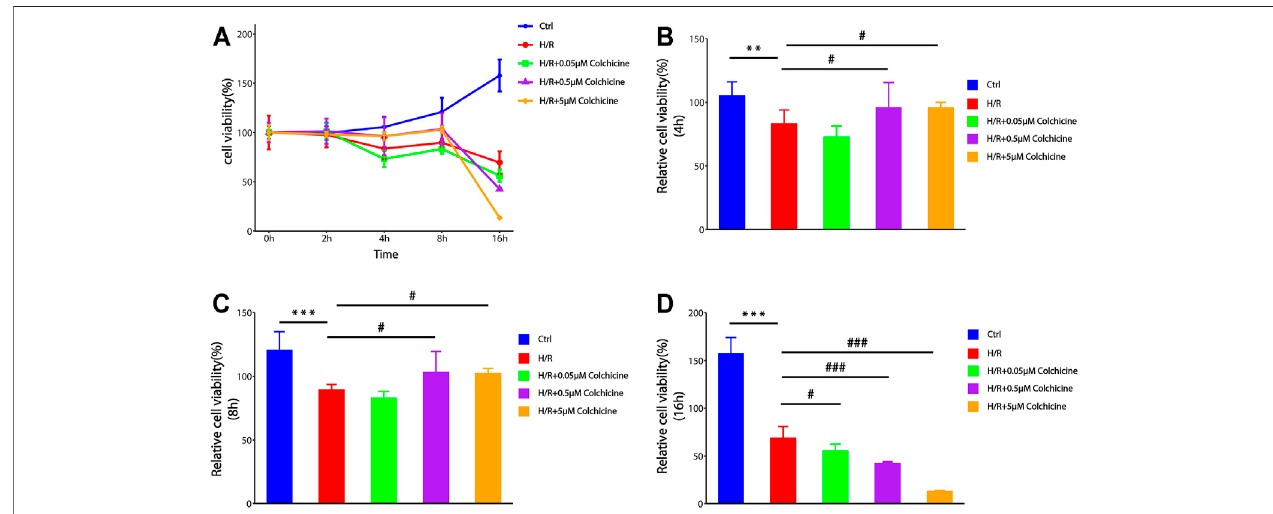
FIGURE 8 | The effect of different concentrations of colchicine and different time of H/R-damaged on the viability of H9C2 cell by CCK-8 assays. (A) Optimum concentration of colchicine in appropriate time H/R-damaged was determined by CCK8 assay. (B – D) The effect of different colchicine concentrations on H9C2 cell viability after 4 h/8 h/16 h H/R injury (*** p < 0.001, ** p < 0.01 compared with control; # p < 0.05, ### p < 0.001 compared with H/R group).